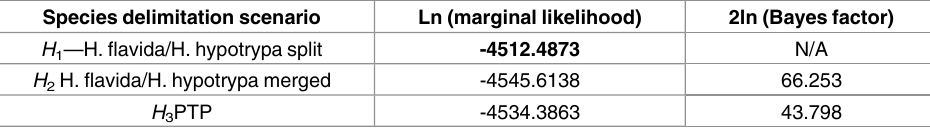
Table 3. Marginal likelihood and Bayes factor values for alternative species delimitation